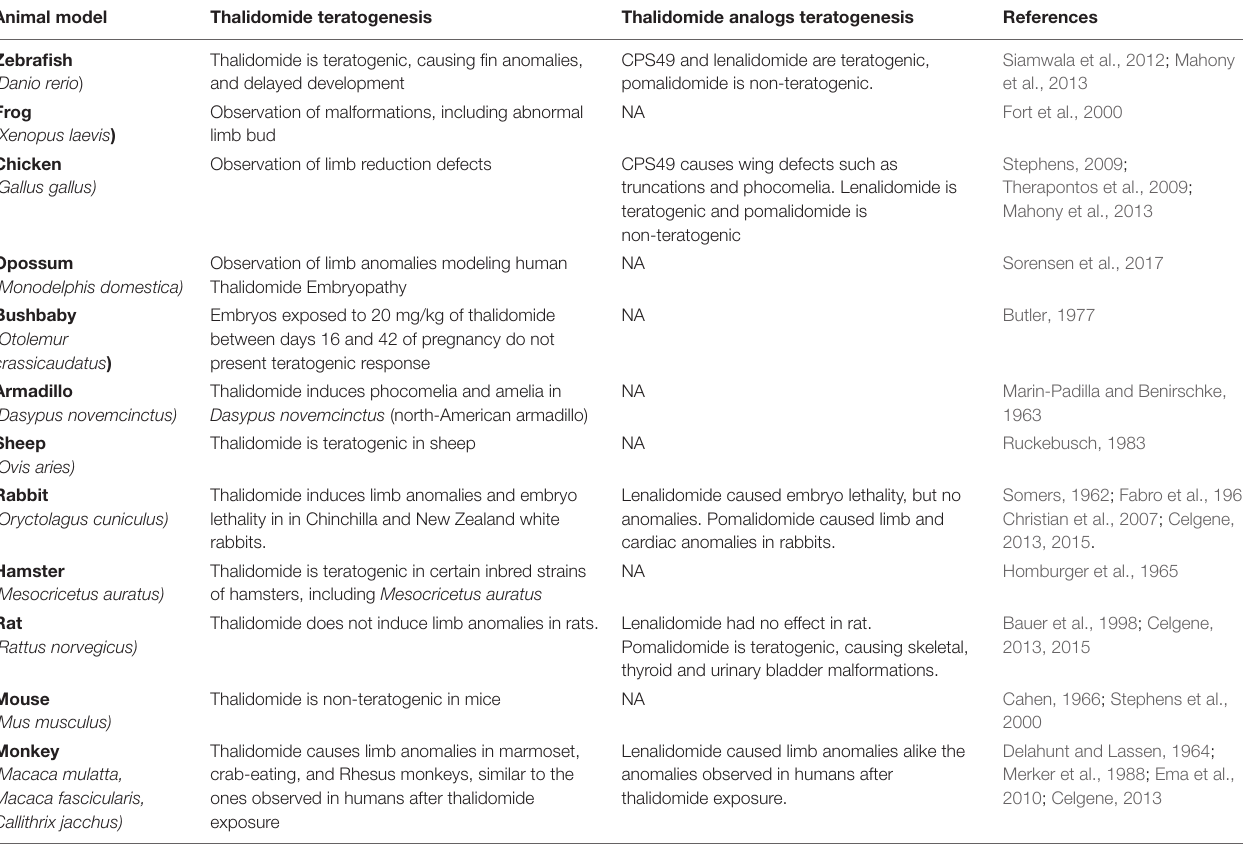
TABLE 1 | Comparative table of the effects of thalidomide, and its analogs, exposure in different animal